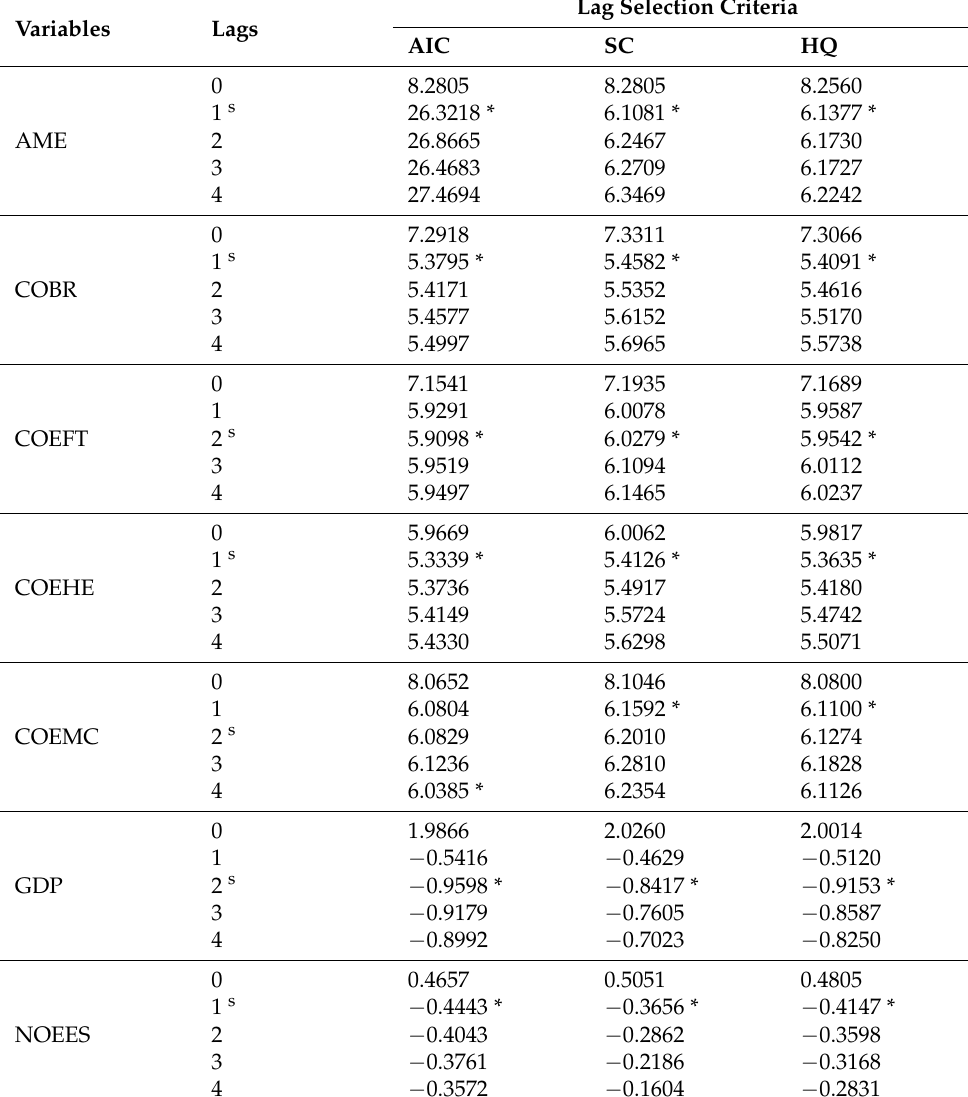
Table 2. Optimal lag length.